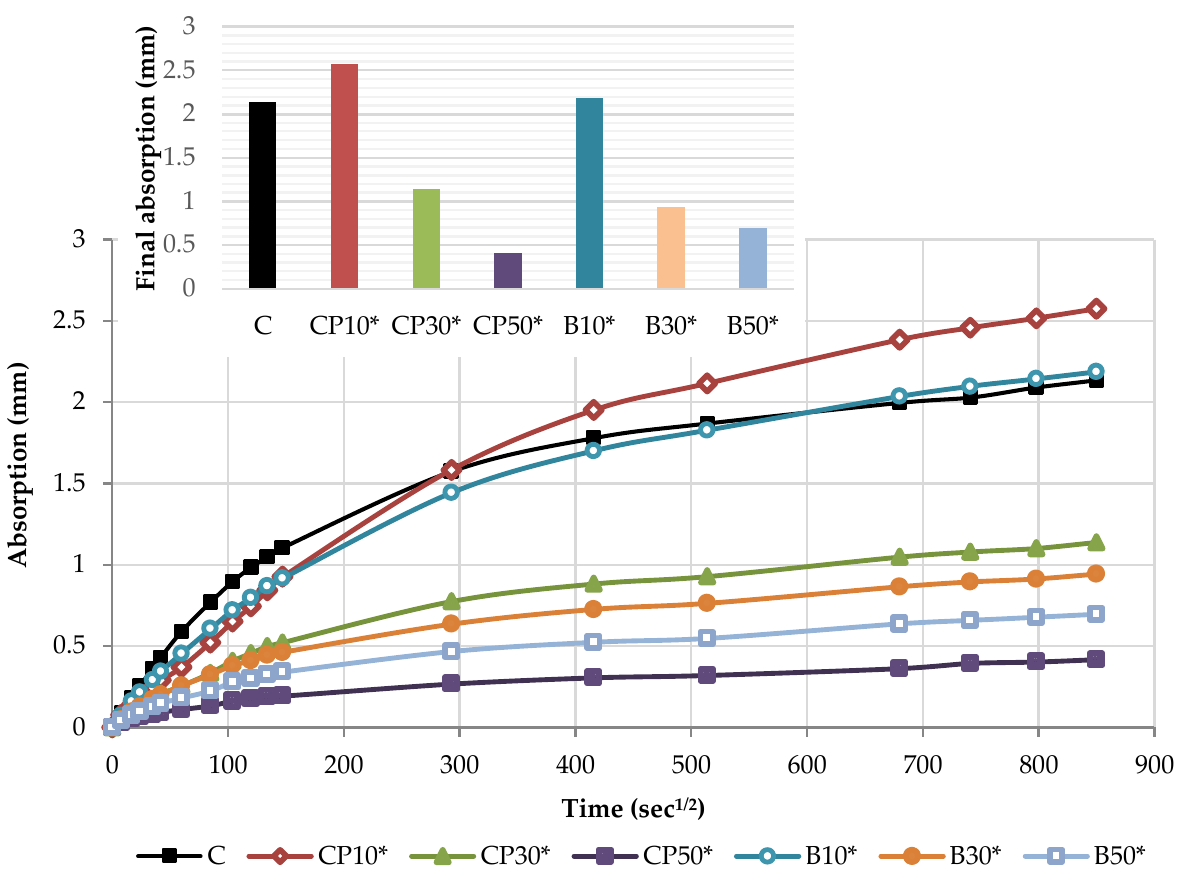
Figure 17. Capillary water absorption of mortars with decreased w/b: the kinetics and the final val- ues.